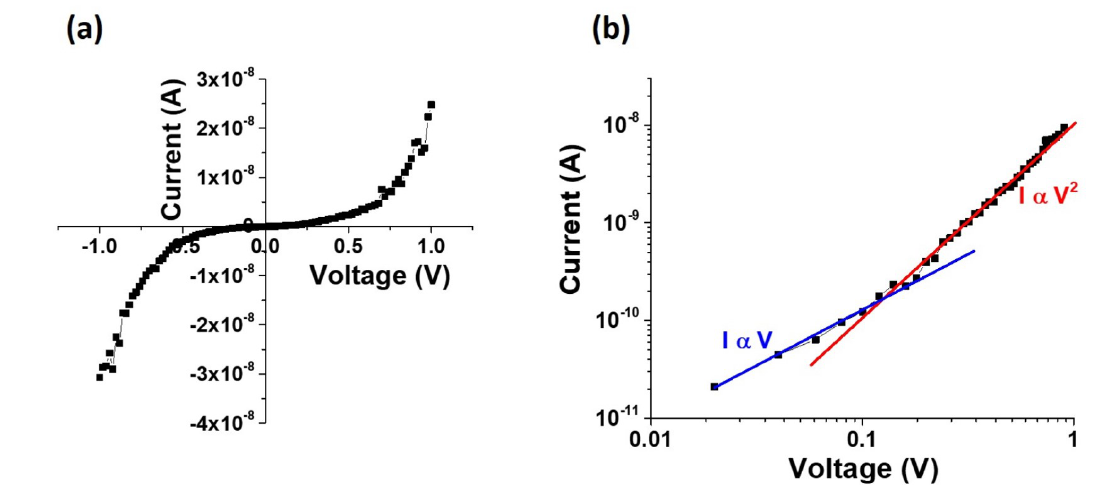
Figure 11. Current–voltage measurements on a single as-grown Insb nanowire. The nanowire diameter and electrode spacing are 190 nm and 1.5 µ m, respectively. ( a ) symmetric nonlinear I–V curve on linear scale. The curves are linear (ohmic) at small bias and transforms at a high bias; ( b ) I–V curves plotted on a logarithmic scale, showing a crossover to space charge limited current (SCLC) at V x = 0.14